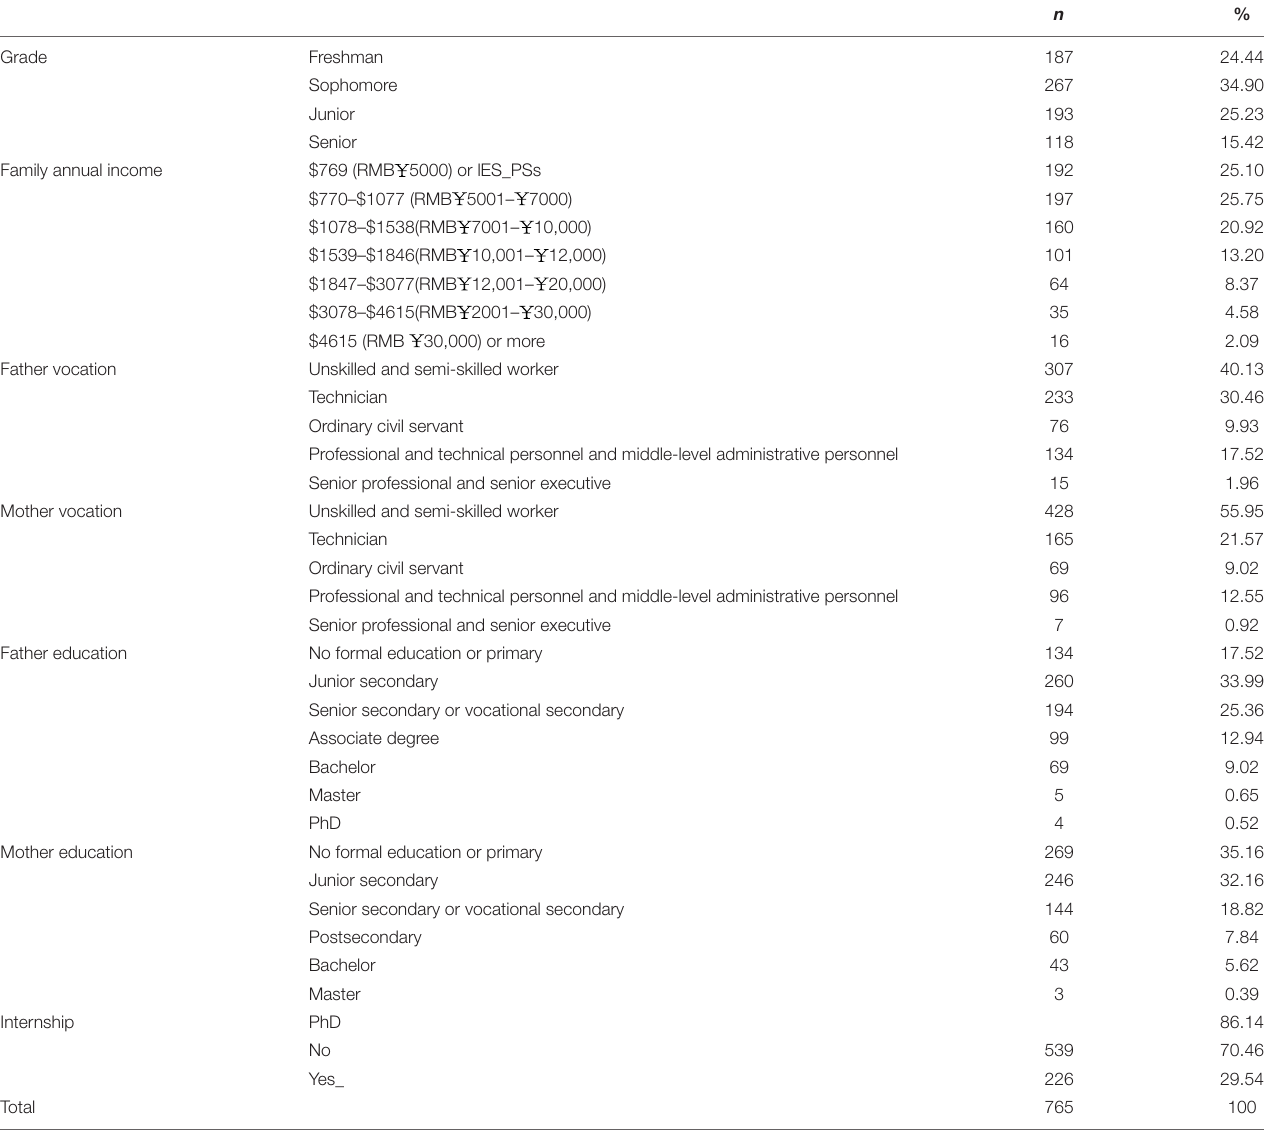
TABLE 1 | Frequencies of the demographic